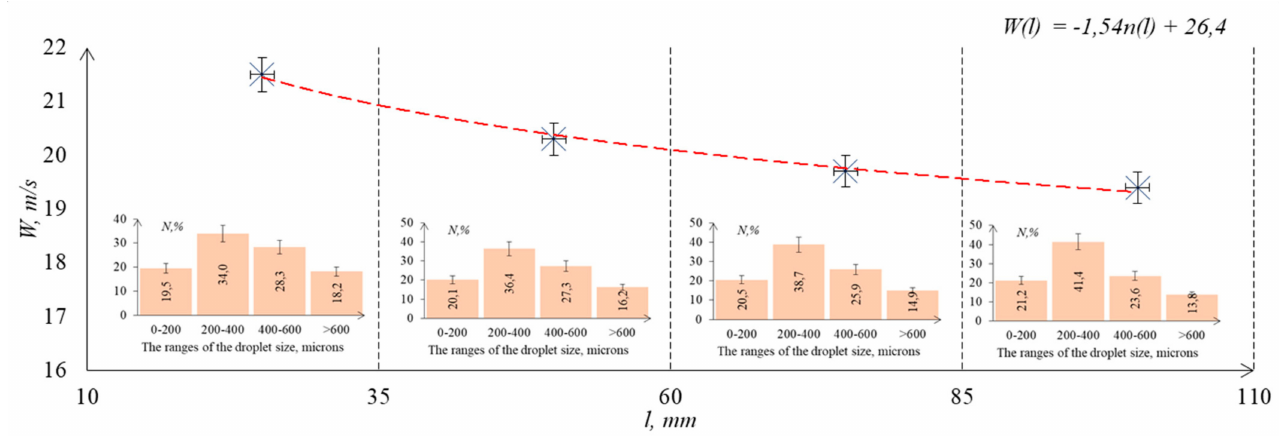
Figure 10. Change in the velocity of liquid hydrocarbon droplets along the longitudinal